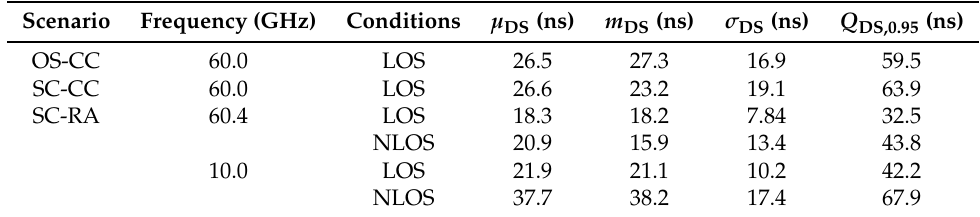
Figure 5. Empirical complementary cumulative distribution functions (CCDFs) of the root mean square (RMS) delay spread (DS) for all measured and simulated UMi line-of-sight (LOS) scenarios. Table 3. Statistical parameters of the root mean square (RMS) delay spread (DS): mean µ DS , standard deviation σ DS , median m DS and 95%-quantile Q DS,0.95